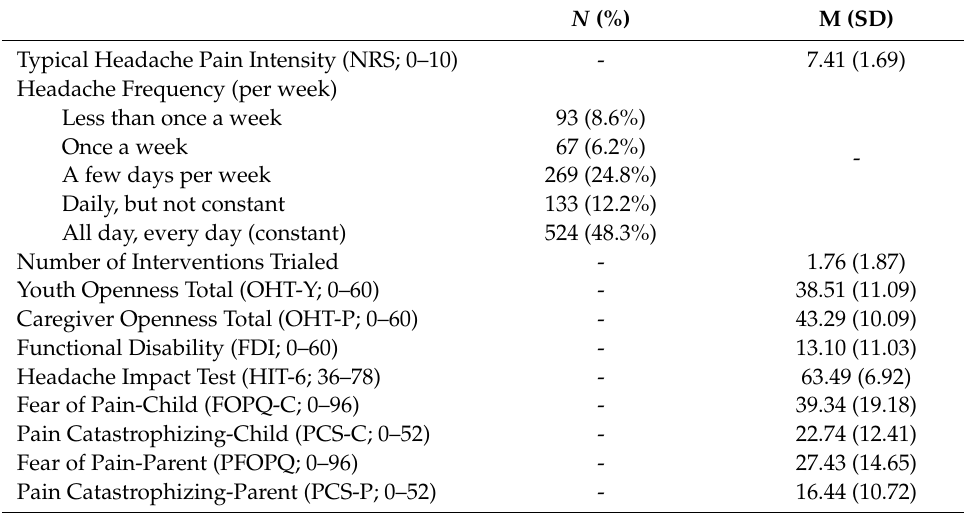
Table 2. Descriptive Statistics for all Study Measures.